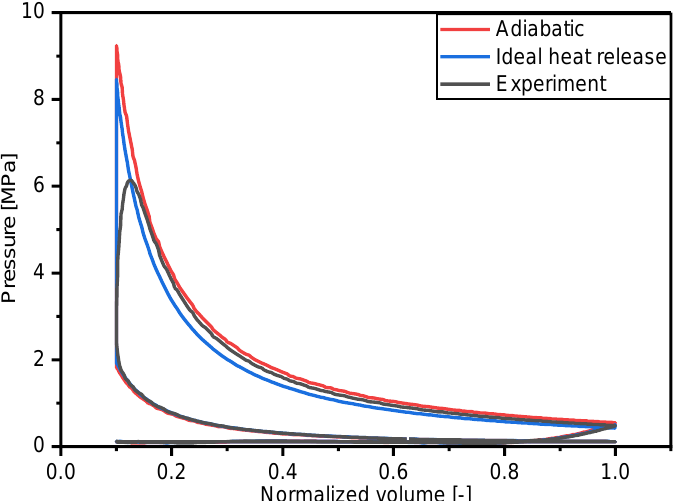
Figure 2. Thermodynamic model validation with experiment (T steam = 473 K; M steam = 0.03 g/cycle; P steam = 15 MPa; P inkate = 0.1 MPa; CR = 10).